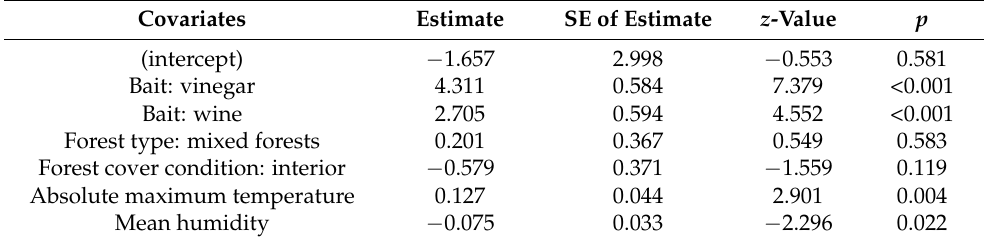
Table 4. Exotic species. Effectiveness of baits in attracting individuals of all species pooled together, accounting for the effects of habitat and meteorological covariates considered in the negative binomial regression model.